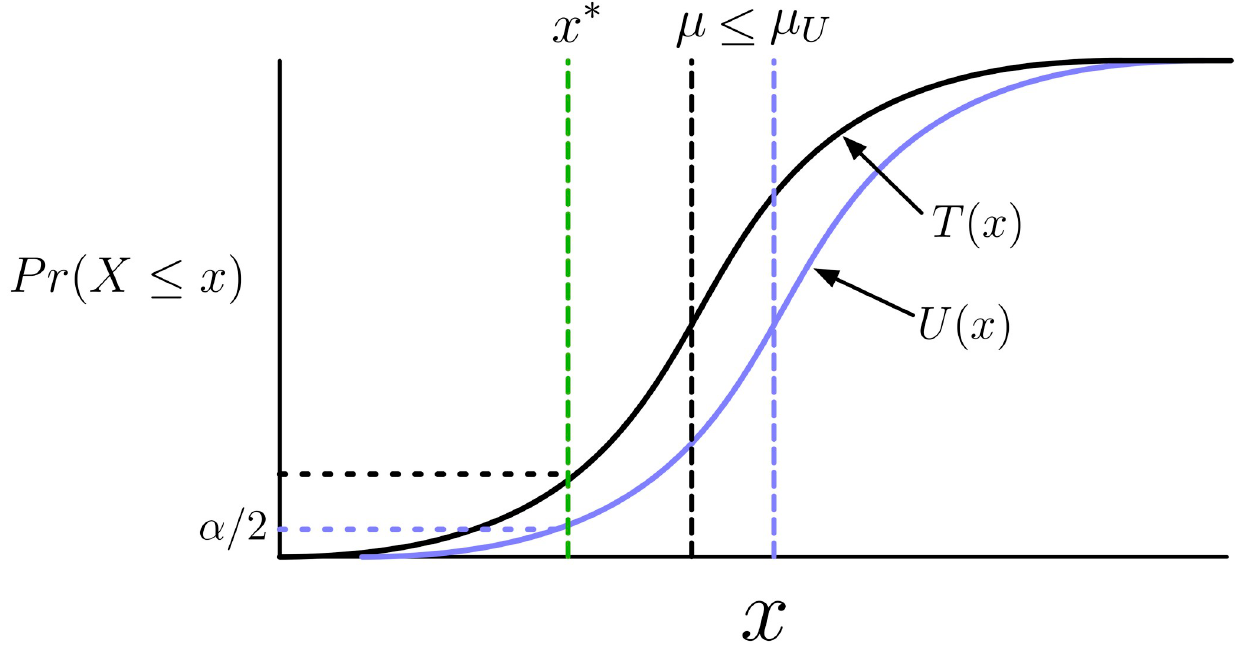
Fig 14. Illustrative schematic of confidence interval estimation. Given an observed estimate x � (green dashed vertical) from the distribution of the estimator X with CDF T ( x ) (solid black curve) associated with the parameter being estimated μ (black dashed vertical), the upper limit of the α -level confidence interval is the μ (purple vertical dashed) corresponding to the cumulative distribution of X , U ( x ) (solid purple curve) that would generate U U values less than x � with probability α /2 (purple horizontal dashed). Thus U ( x ) is defined by U ( x � ) = α /2. Under the assumption the family of CDFs of X are , thus the upper limit of the confidence interval contains the stochastically increasing in μ , the event that T ( x ) � α /2 corresponds to the event that μ < μ U true value of μ . In graphical terms, if the black horizontal dashed line is above the purple, then it is guaranteed that the purple vertical dashed is to the right of the black. Thus these two events have the same probability: Pr ( μ � μ U ) = Pr ( α /2 � T ( X )) = 1 − α /2. Here we have used generic symbols for illustrative purposes, but for reference to the proof (see Methods, “Proof of α -level confidence intervals”), the notation used here correspond as follows: X ¼ ^ r 2 ER